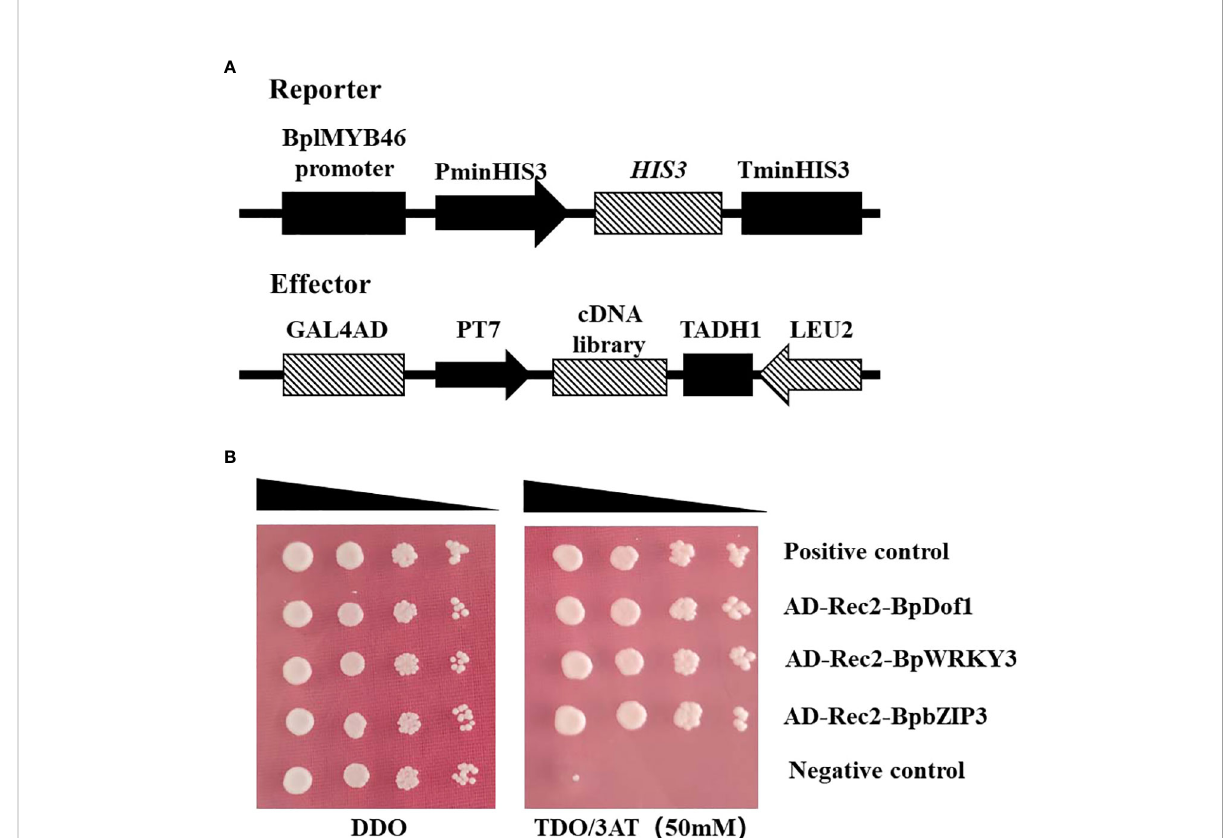
FIGURE 4 Three regulatory factors that bound to the BplMYB46 promoter were identi fi ed from the birch cDNA library via Y1H analysis. (A) Schematic diagram of the effector and reporter used in the Y1H analysis. (B) Veri fi cation of the birch cDNA library (effector) and the BplMYB46 promoter (reporter) constructs co-transformed into yeast Y187 cells. The positive transformants were determined by spotting the serial dilutions (1:1, 1:10, 1:100, and 1:1000) of yeast onto DDO and TDO plates with 3-AT. Positive control: pGADT7-p53/pHIS2-p53; Negative control: pGADT7-p53/ pHIS2- BplMYB46 promoter.